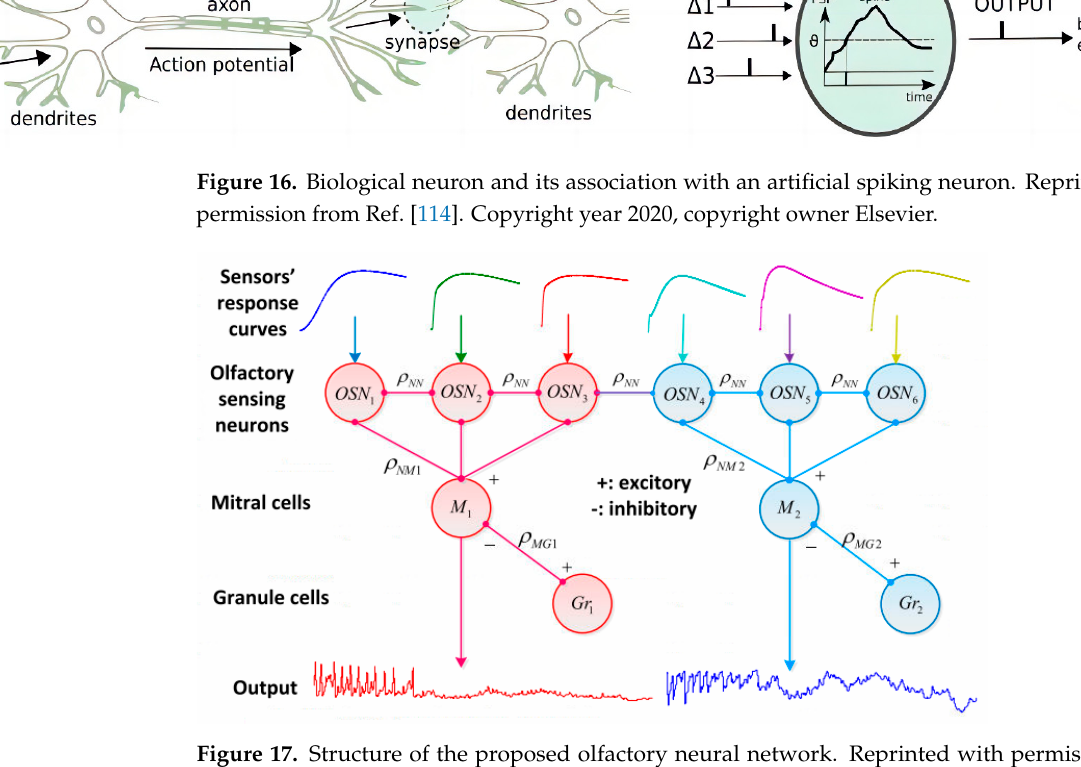
Figure 17. Structure of the proposed olfactory neural network. Reprinted with permission from Ref. [115]. Copyright year 2016, copyright owner IEEE .